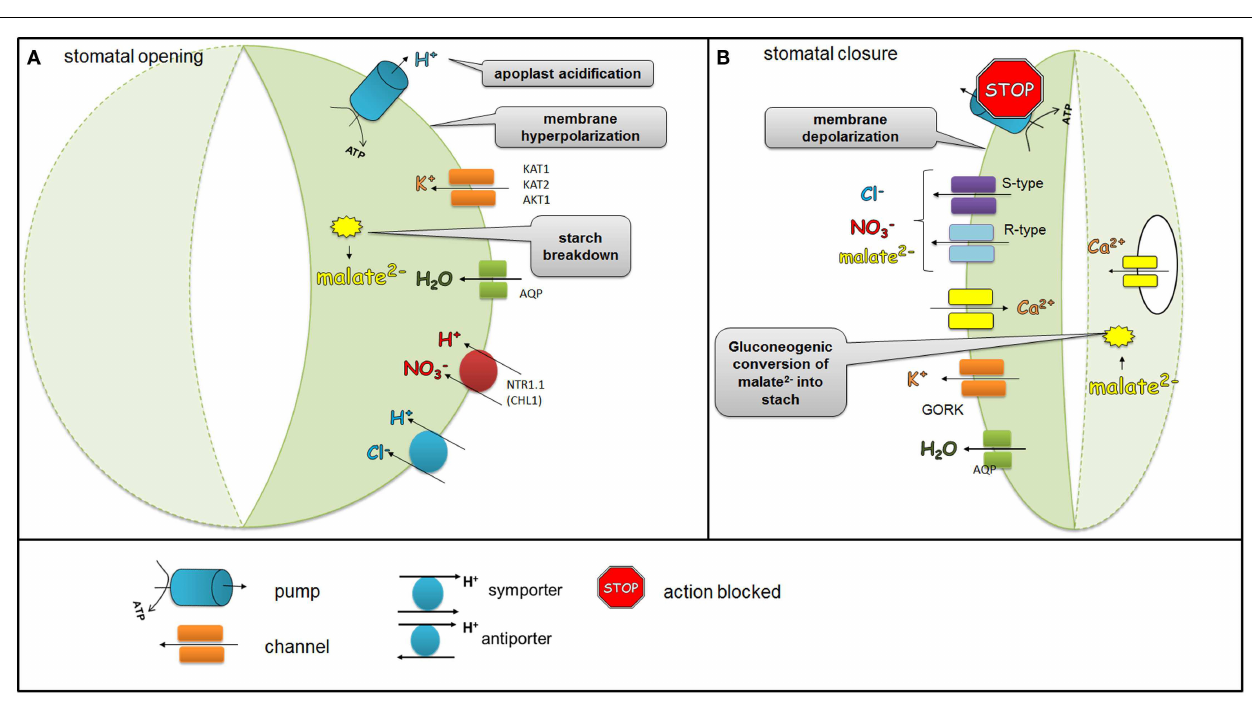
FIGURE 1 | Regulation of ion channels, pumps, and transporters localized in the plasma membrane of the guard cells during stomatal opening and closure . During stomatal opening (A) H + -ATPase pumps H + from the guard cells and hyperpolarizes the membrane, which leads to the activation of K + inward rectifying channels (KAT1, KAT2, AKT1). Anionic species such as malate 2 − from the breakdown of starch and transported NO − and Cl − ions contribute to the intracellular solute buildup that can 3 mediate the import of sugars or can be used for the synthesis of sugars. Ions supplied into the guard cells together with water transported via aquaporins generate the turgor that is needed to keep stomata opened.